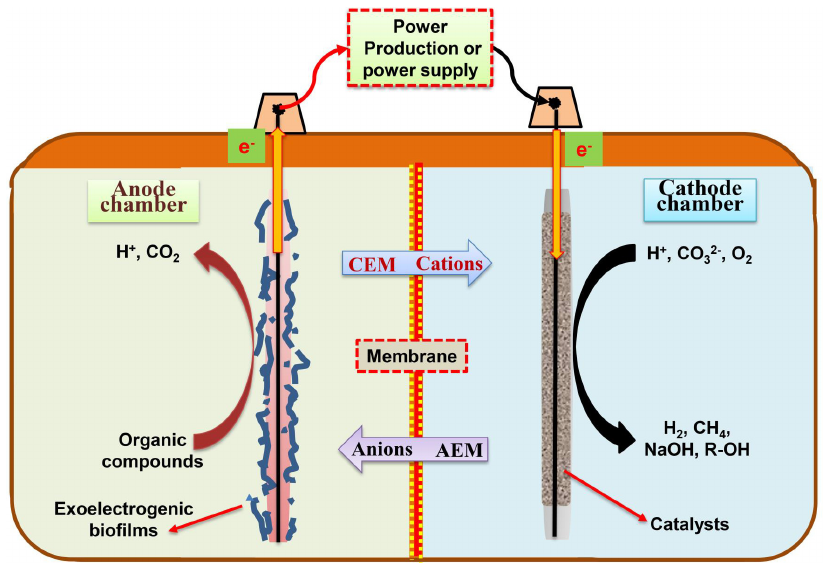
Figure 1. A general schematic of bioelectrochemical systems (BES), CEM—cation exchange membrane, AEM—anion exchange